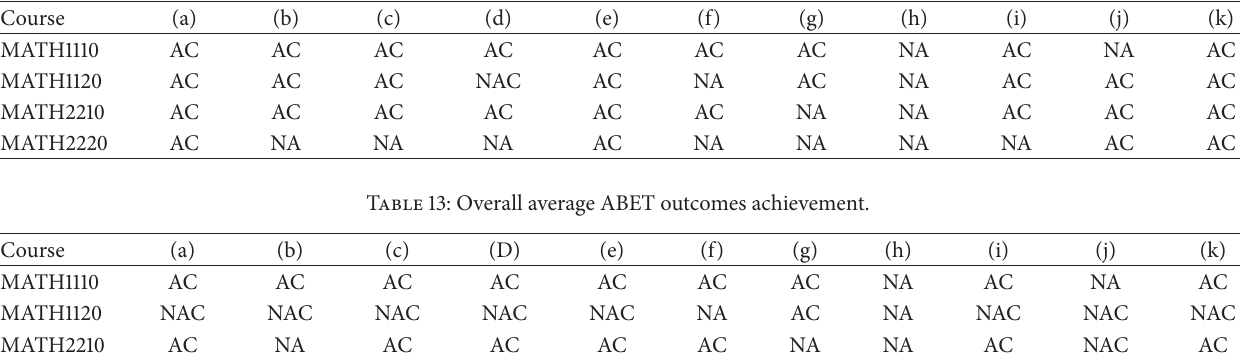
Table 12: Average ABET outcomes achievement level based on the indirect assessment tool “students opinion” (AC: achieved, NAC: not achieved, and NA: not applicable).